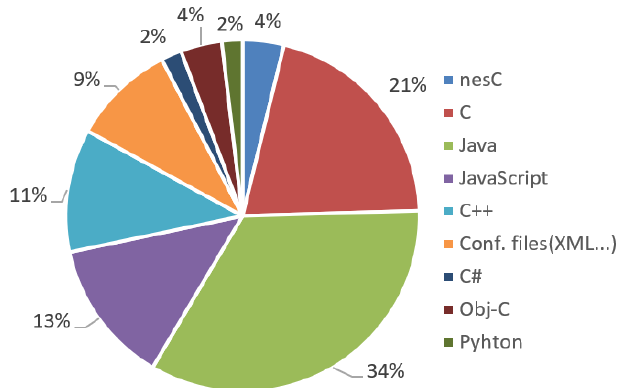
Figure 5. The percentages of the modeling languages that support different programming lan- guages.